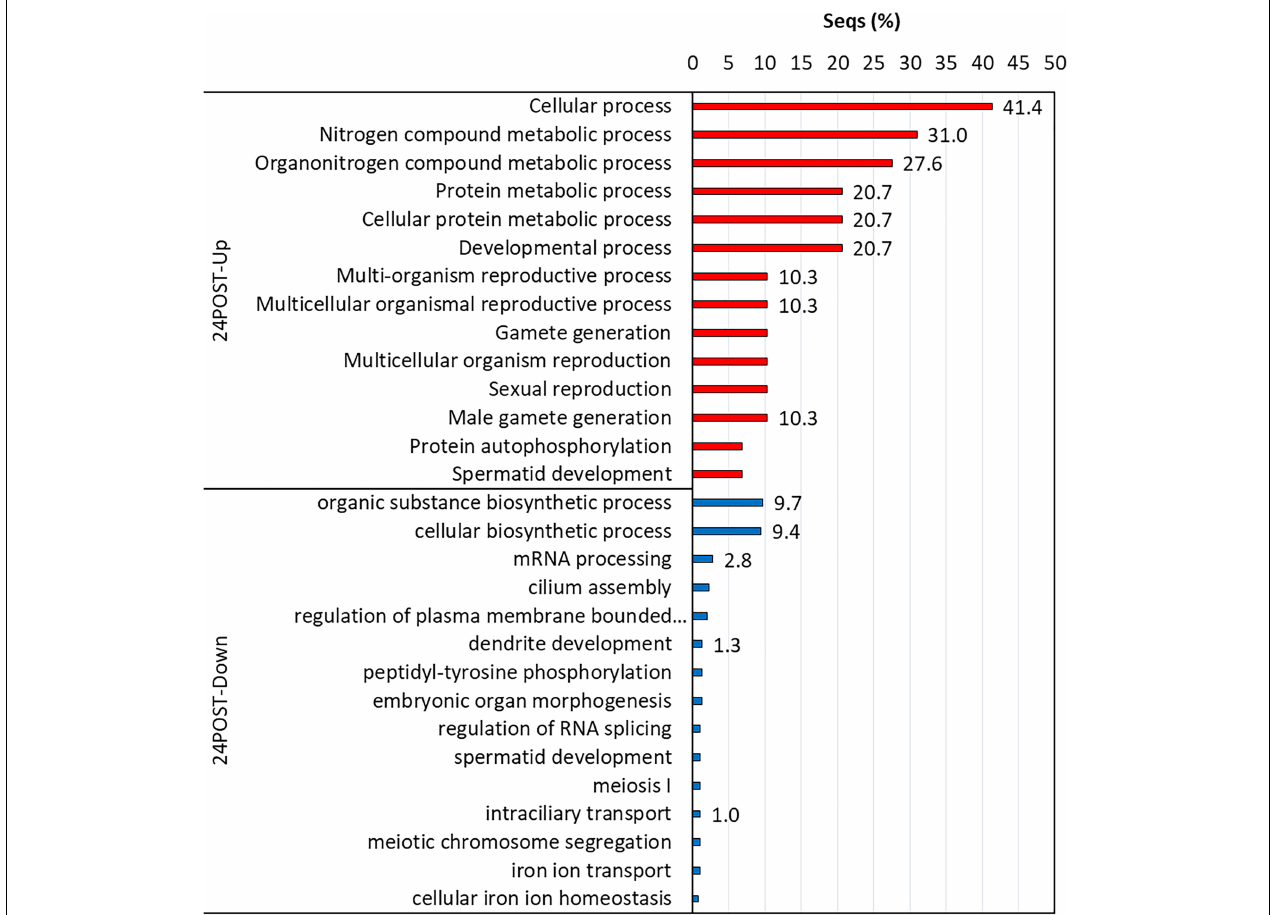
FIGURE 5 | Enriched GO terms of biological processes (Fisher exact test, FDR < 0.05) in 24POST treatment vs. the control treatment (24PRE). Up (red) and down-regulated (blue) transcripts are